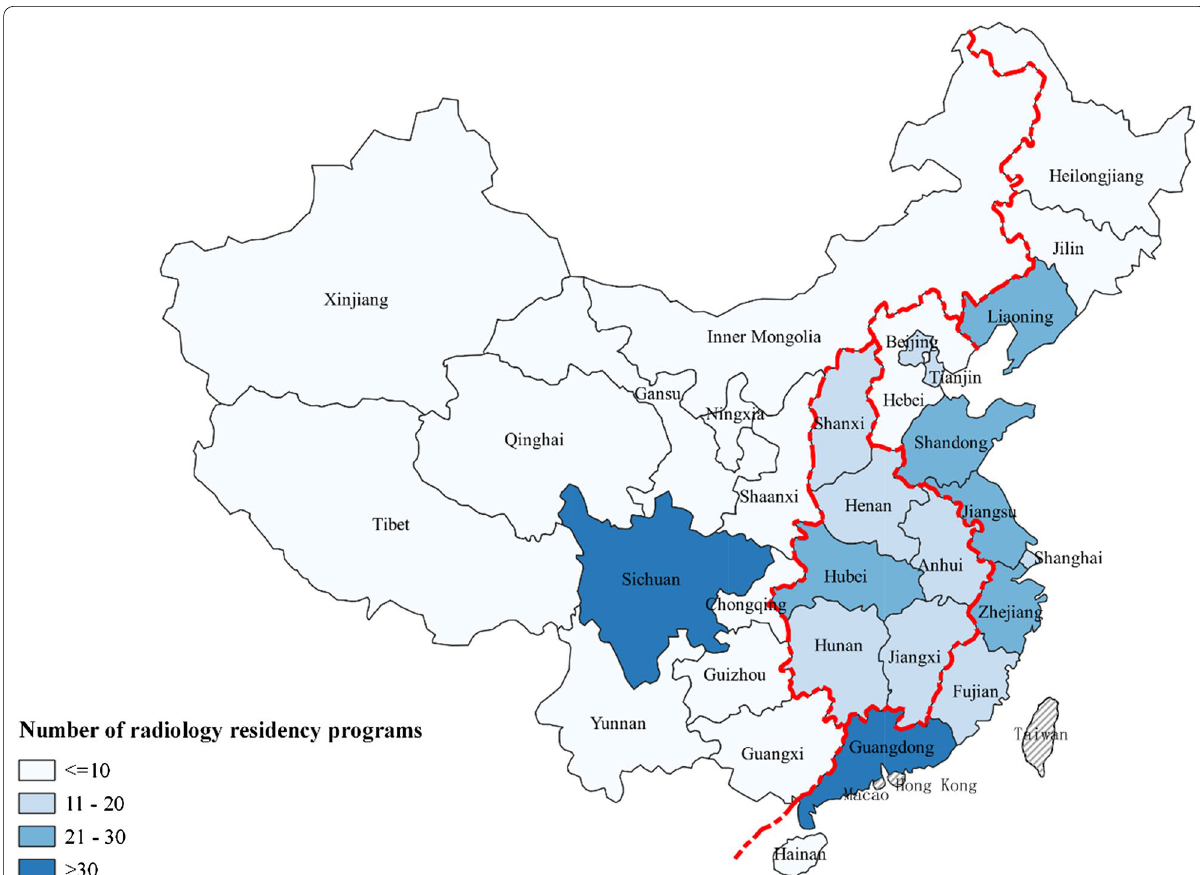
Fig. 1 Geographic distribution of radiology residency programs in China. Note: The four regions were defined by China’s National Bureau of Statistics based on the geographic location and economic status. The eastern region contains 10 highly developed coastal provinces and municipalities, including Beijing, Tianjin, Hebei, Shanghai, Jiangsu, Zhejiang, Fujian, Shandong, Guangdong and Hainan. The central region includes 6 provinces, including Shanxi, Anhui, Jiangxi, Henan, Hubei and Hunan. The western region includes 12 less developed provinces and municipalities,